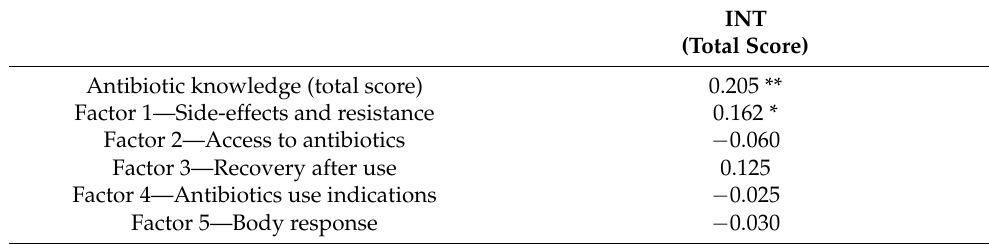
Table 5. Pearson correlation coefficient between the AKCT and